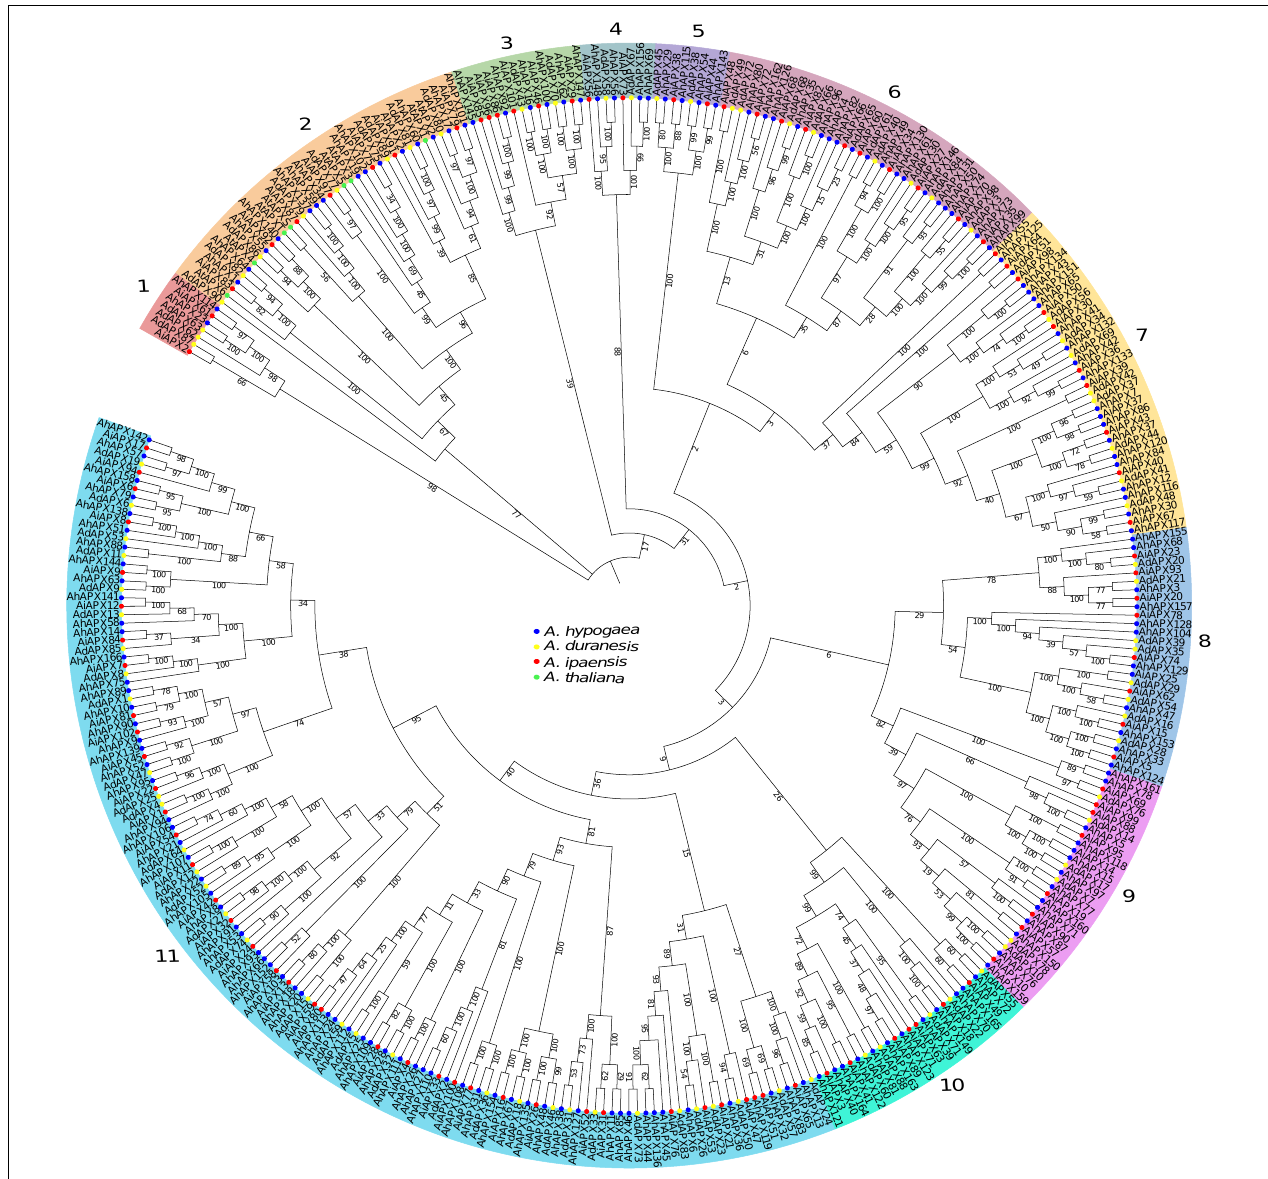
FIGURE 2 | An unrooted neighbor-joining phylogenetic tree of APX proteins from A. hypogea, A. duranensis, A. ipaensis, and A. thaliana . On the whole, 166 AhAPXs from A. hypogea (blue circles), 90 AdAPXs from A. duranensis (yellow circles), 102 AiAPXs from A. ipaensis (red circles), and 8 AtAPXs from Arabidopsis thaliana (green circles) were clustered into 11 groups based on sequence similarities, domain, and 1,000 bootstrap values. The percentage of bootstrap values is shown in the notes.